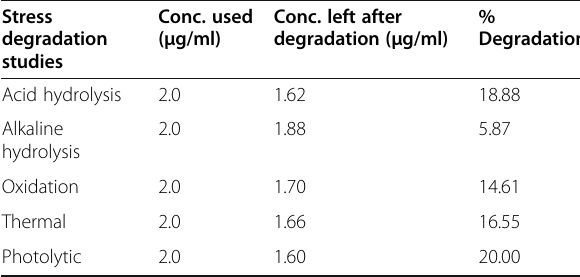
Table 7 Results of the stress degradation studies of apigenin solution at 2 h